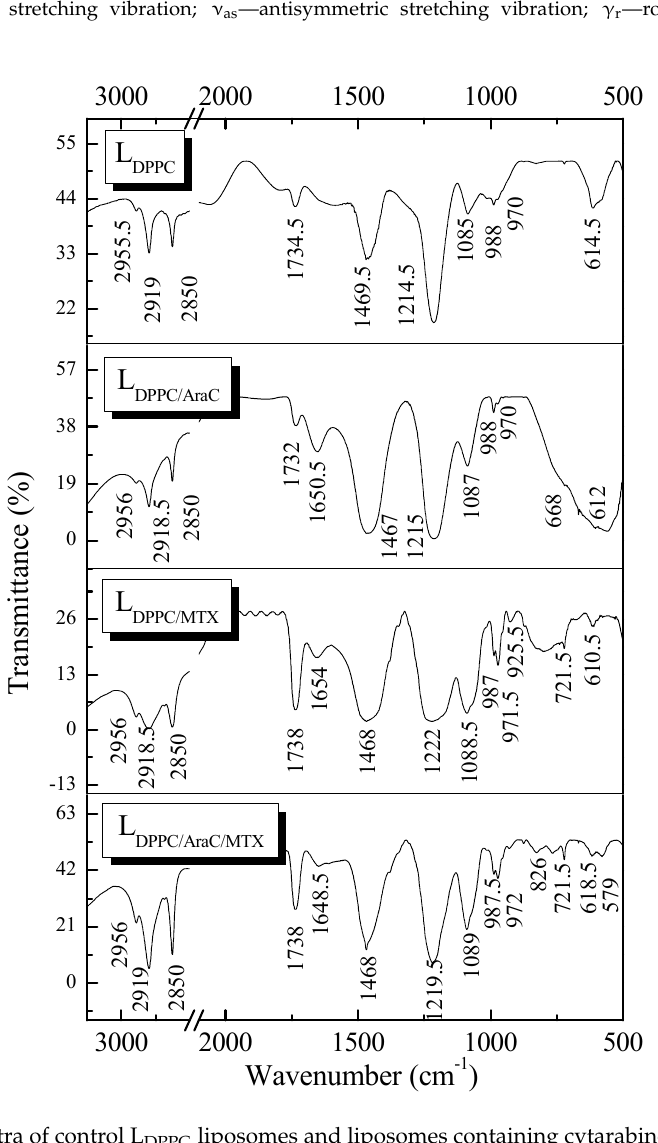
Figure 5. FT-IR spectra of control L DPPC liposomes and liposomes containing cytarabine and methotrexate. The effects include changes in electron density and bond lengths. A strong wide band in the spectral region of ~1214 cm − 1 was also observed. This band is attributed to the asymmetrical stretching